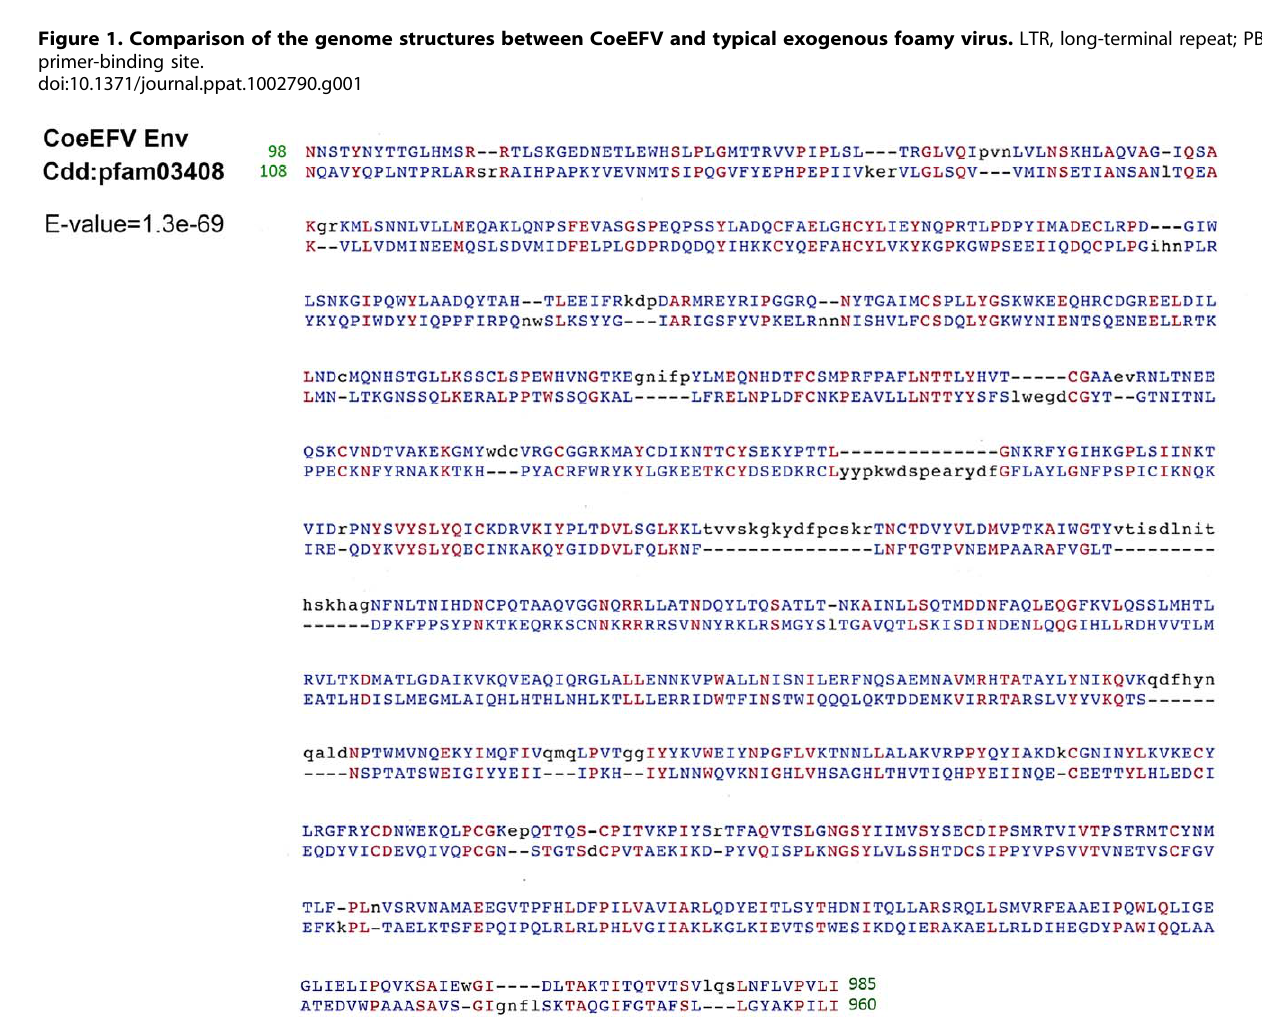
Figure 2. Conserved domain alignment of the CoeEFV Env protein and foamy virus envelope protein domain (pfam03408). Numbers refer to the position in the original CoeEFV env protein or conserved domain pfam03408. Identical amino acid residues are highlighted in red, and black and blue indicate gaps or different amino acid residues, respectively. The E-value was generated by Conserved Domain search.